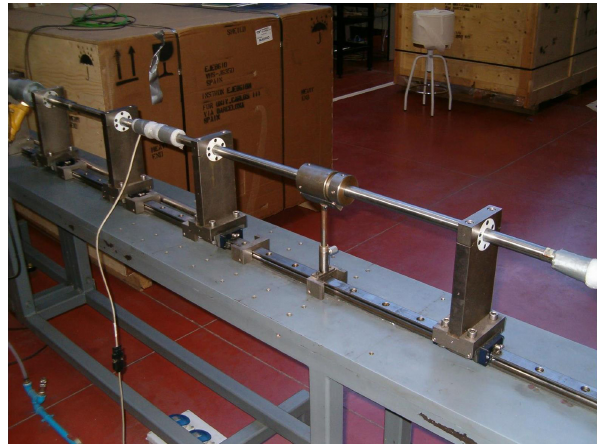
Figure 24. Experimental apparatus ready for the experiment.